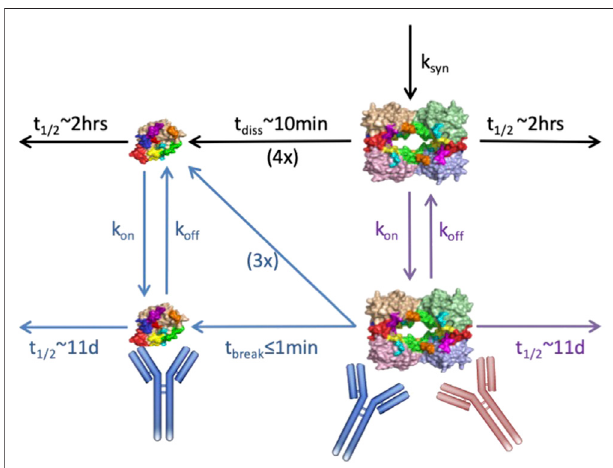
FIGURE 3 | Schematic of anti-tryptase PKPD model with lung compartment shown. Mechanisms represented include: tryptase tetramer secretion in the lung, physiological dissociation of tetramer to four monomers, antibody binding to/dissociation from the monomeric, and tetrameric forms, as appropriate, and binding induced disruption vs. stabilization of the tetramer. Black arrows represent physiological mechanisms; red antibody/ arrows pertain to tetramer-selective stabilizing molecule; blue antibody/ arrows pertain to destabilizing molecule; purple arrows pertain to both. Standard two-compartment systemic/peripheral nonspeci fi c PK augmented by binding to monomer in the serum, and drug partitioning to lung were also included in the model but are not